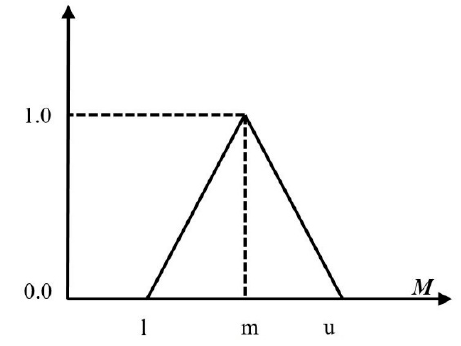
Figure 5. Triangular fuzzy number.